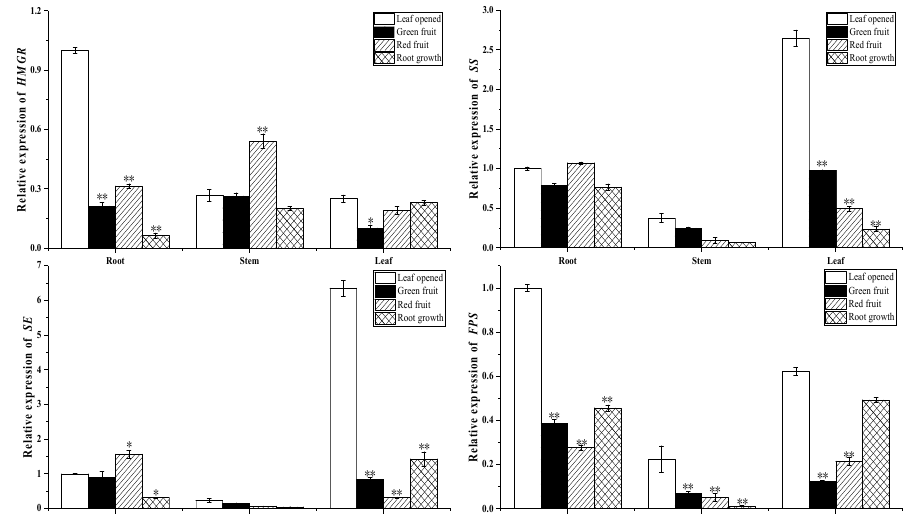
Figure 6. Expression of genes related to ginsenoside biosynthesis in roots, stems, and leaves during different growth times. The relative expression of ( A ) HMGR, ( B ) SS, ( C ) SE, and ( D ) FPS genes in the leaf opened, green fruit, red fruit, and root growth stages was analyzed by real-time polymerase chain reaction. Vertical bars indicate the mean ± standard error from three independent experiments. * indicated that the different growth stages are significantly different at the 0.05 level. ** indicated that the different growth stages are significantly different at the 0.01 level.